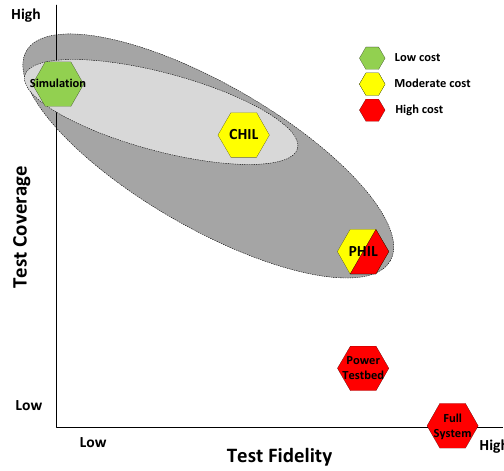
Figure 1. Smart Grid test beds and their comparative (based on [12]): simulation, CHIL, PHIL, power test bed and full